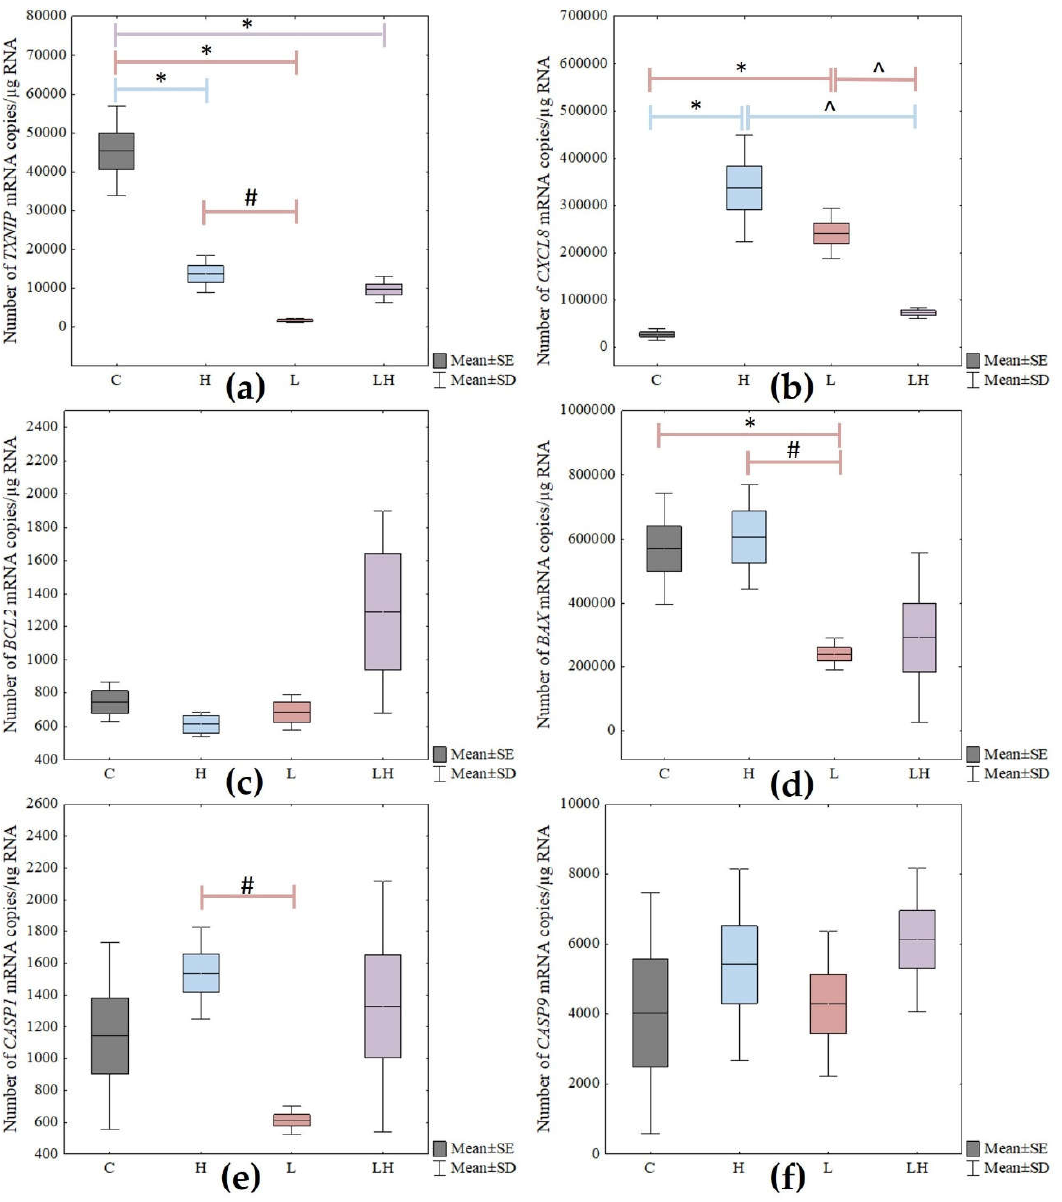
Figure 6. Changes in the mRNA levels of ( a ) TXNIP , ( b ) CXCL8 , ( c ) BCL2 , ( d ) BAX , ( e ) CASP1 , and ( f ) CASP9 genes in senescent retinal pigment epithelial cells after treatment with H 2 O 2 (H), lutein (L), co-treated with lutein and H 2 O 2 (LH), and non-treated cells (C). The box and whisker plots present the mean ± standard error (SE) and standard deviation (SD) of copy numbers per 1 µg of the total RNA; Tukey’s post hoc test; * p < 0.05 versus C; # p < 0.05 versus H; ^ p < 0.05 versus LH. Sample size—three biological and three technical replicates for each test group.